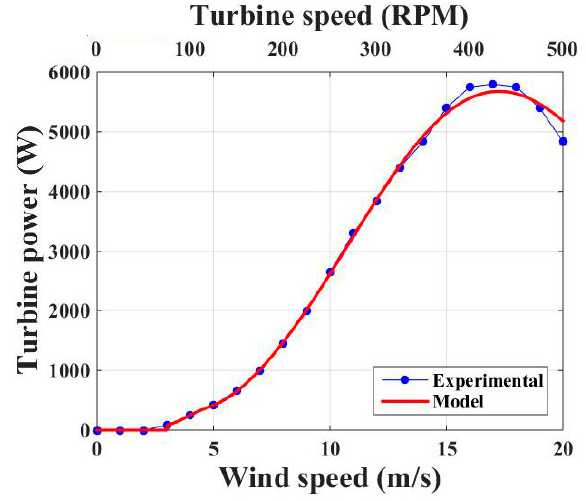
Figure 3. Optimal turbine power versus wind speed.